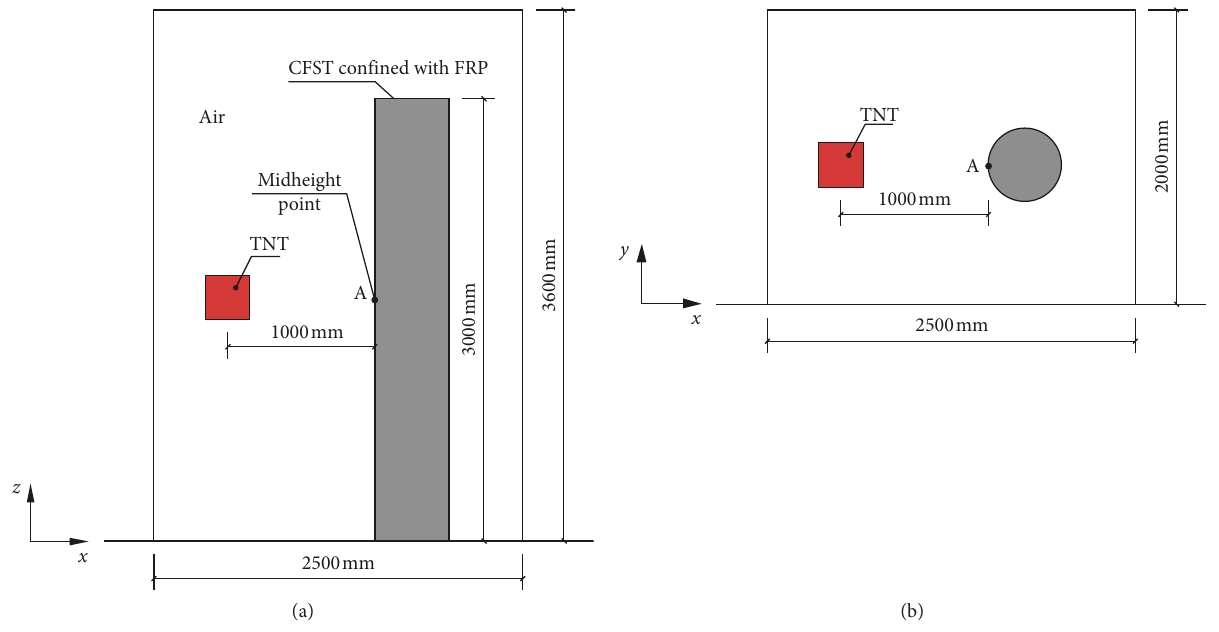
Figure 2: Model of the CFST column confined with FRP under blast loading. (a) Front view. (b) Top view.